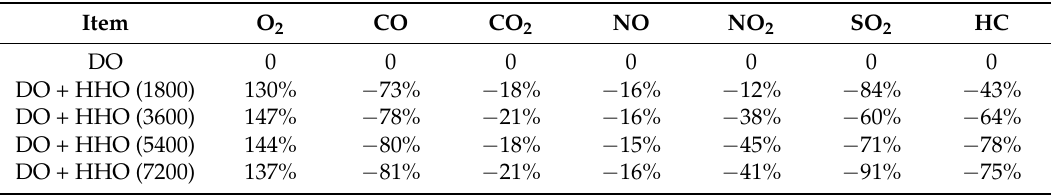
Table 14. Average reductions (%) of various particles when combining DO with various amounts of